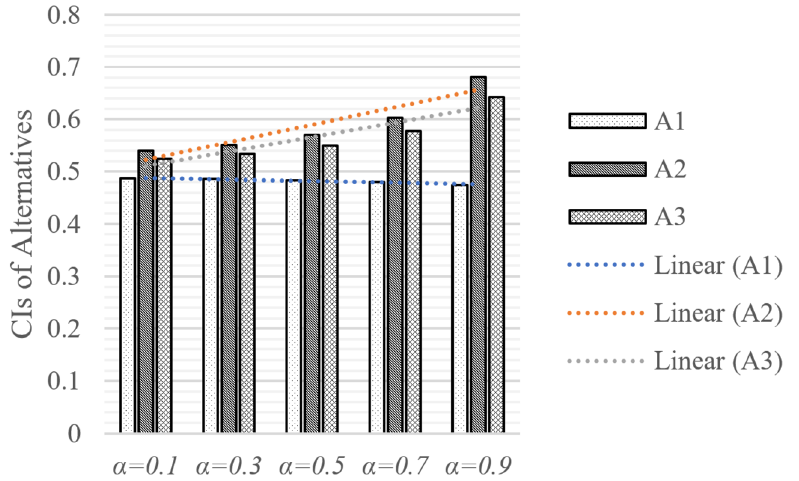
Figure 7. Closeness indices (CIs) of alternatives by different coefficient α.